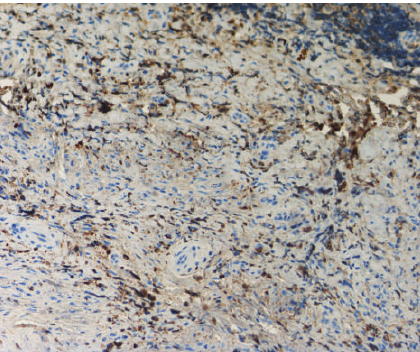
Figure 3: Immunohistochemical staining for total IgG in an area with inflammatory cells. The brown-coloured areas represent IgG. × 200.